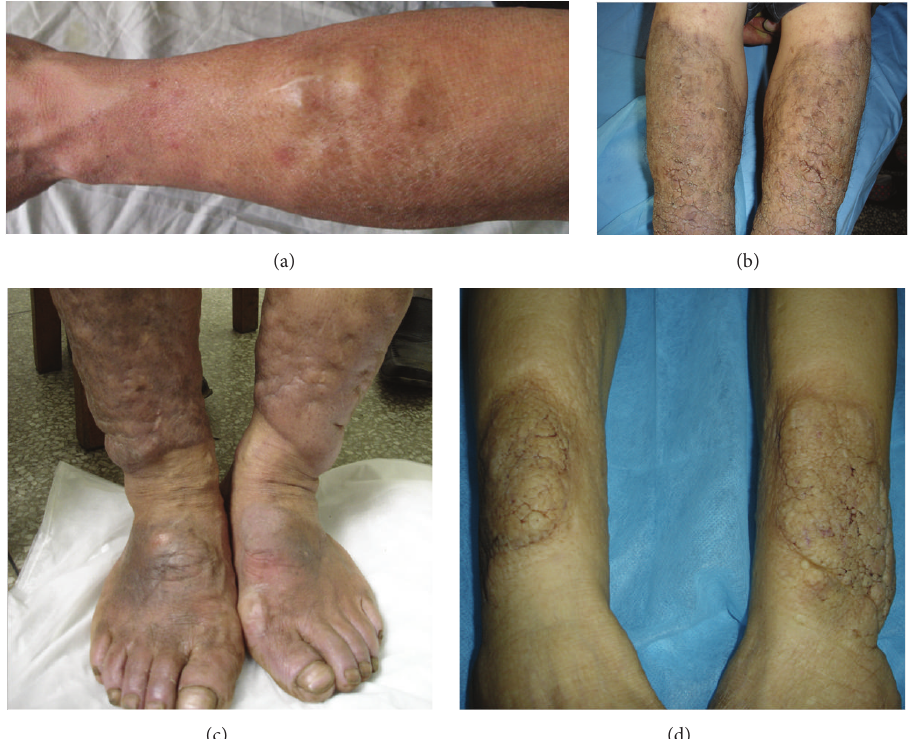
Figure 8: Stable stage. (a) Skin-colored nodules on the legs were kept at the same size for more than 3 months. (b) Well-circumscribed, pigmented, and papillary elephantiasis at stable stage on the legs. (c) Pigmented elephantiasis scattered with pigmented nodules and without erythema at stable stage on the lower extremities. (d) Well-circumscribed, skin-colored plaques with papillary appearance at stable stage on the legs.